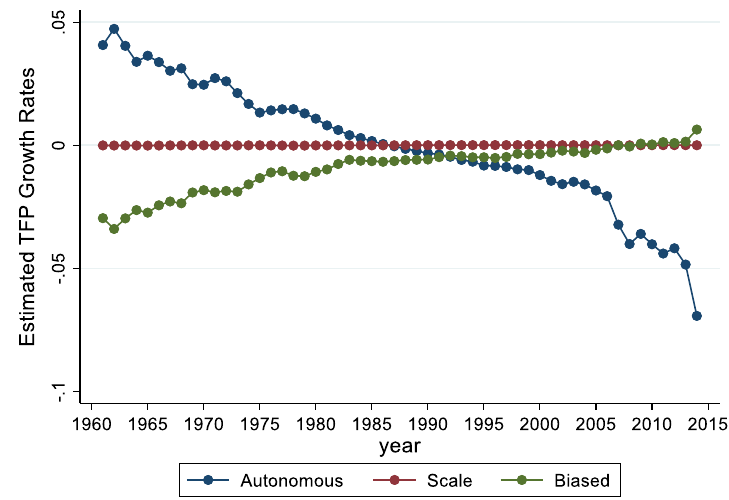
Fig. 9 Decomposition of TFP growth